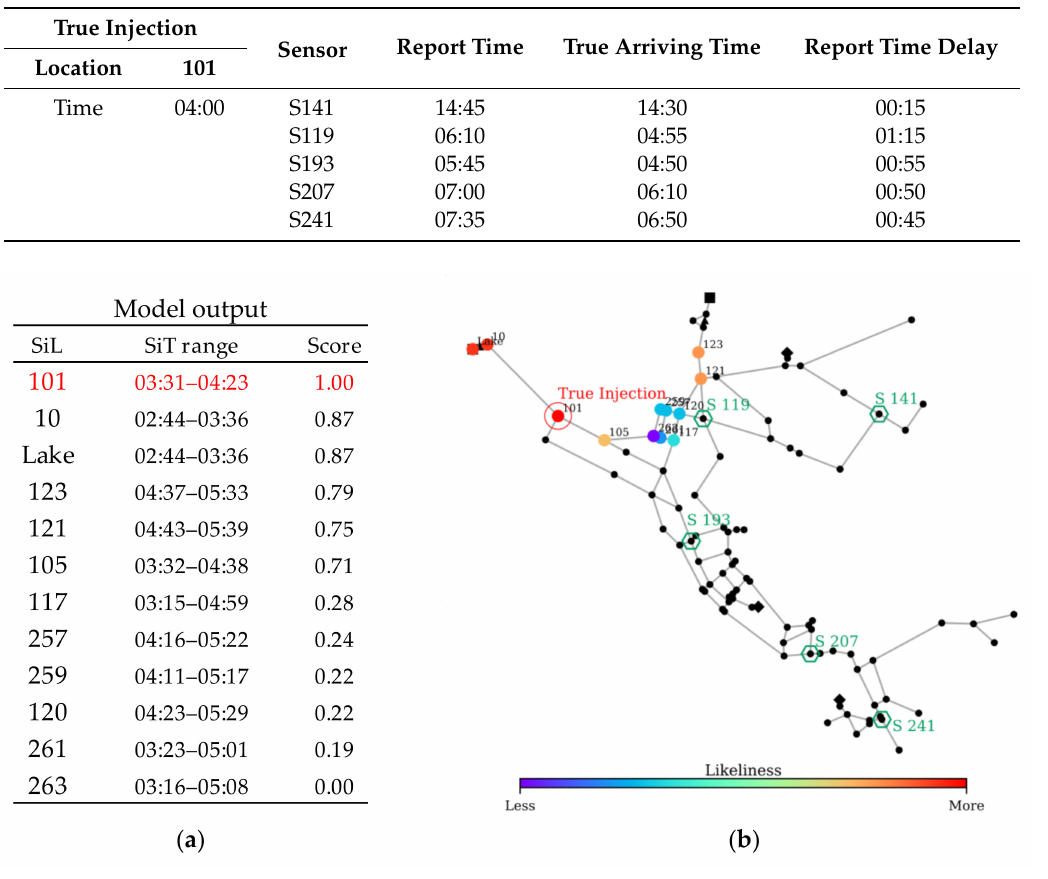
Table 7. True injection and sensor information (scenario 1).